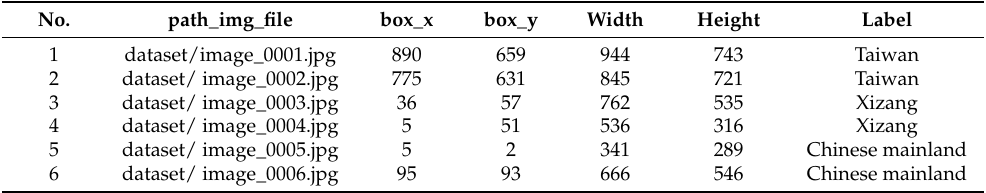
Figure 3. Different thematic maps: ( a ) seismic zone; ( b ) climate; ( c ) transportation and mountain terrain. Table 2. Target annotation